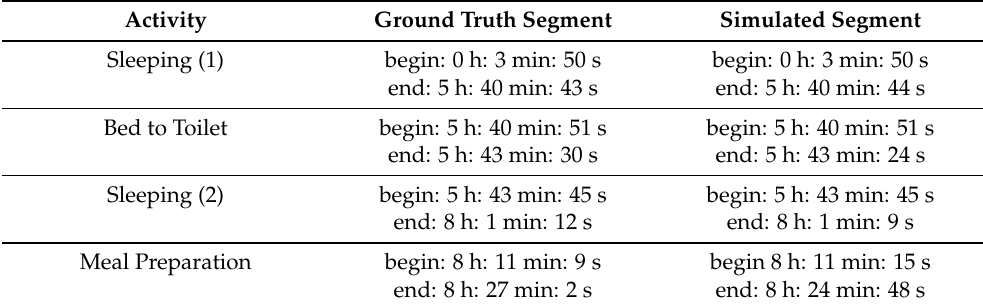
Table 2. Results of segmentation.